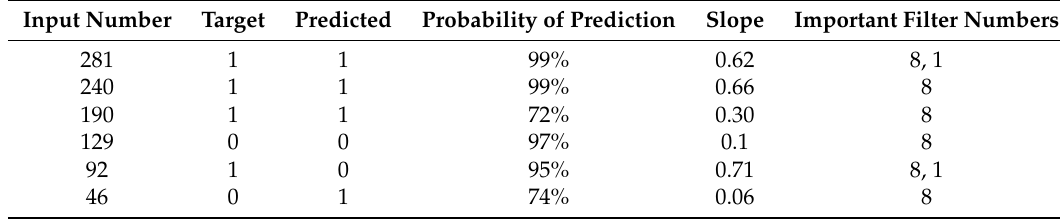
Table 9. Examples of prediction for seven selected validation